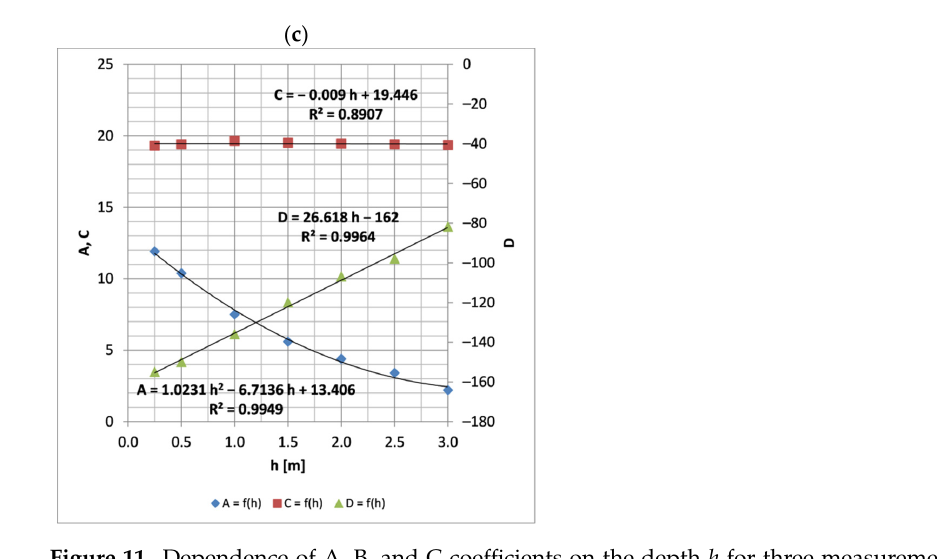
Figure 11. Dependence of A, B, and C coefficients on the depth h for three measurement points: ( a ) No. 1, ( b ) No. 2, ( c ) No. 3.